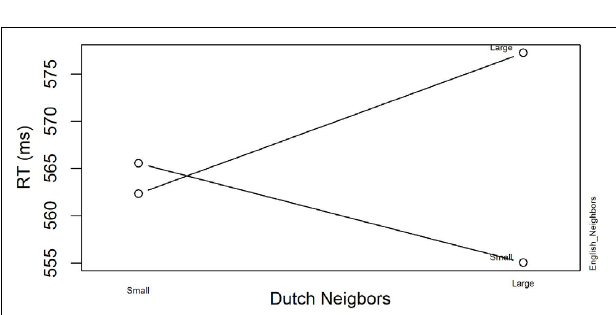
FIGURE 1 | The significant interaction between English Neighbors and Log English Bigram Frequency in English Lexical Decision with neighbors (Experiment